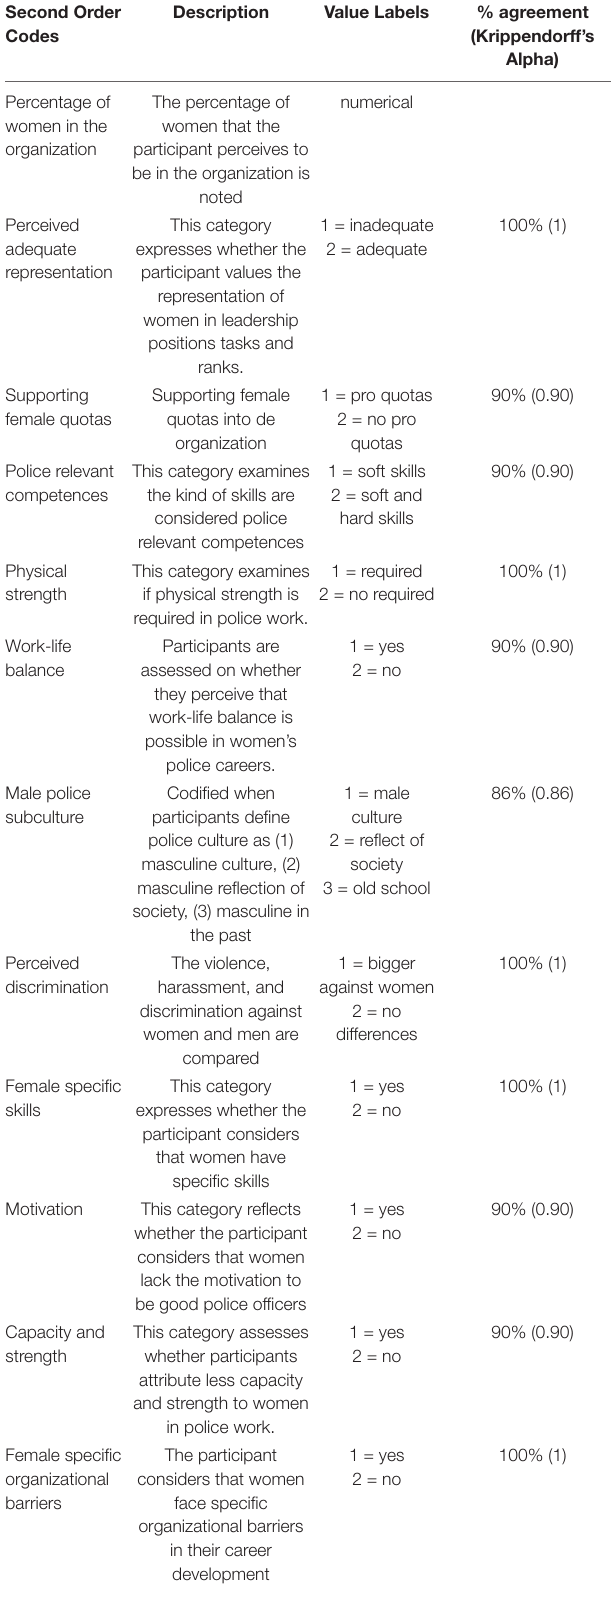
TABLE 3 | Second order codes and value